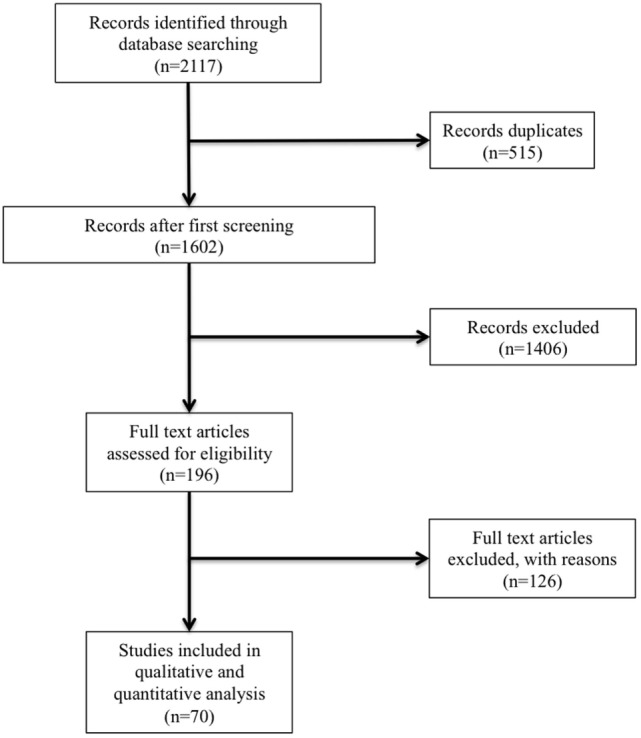
Study flow chart.